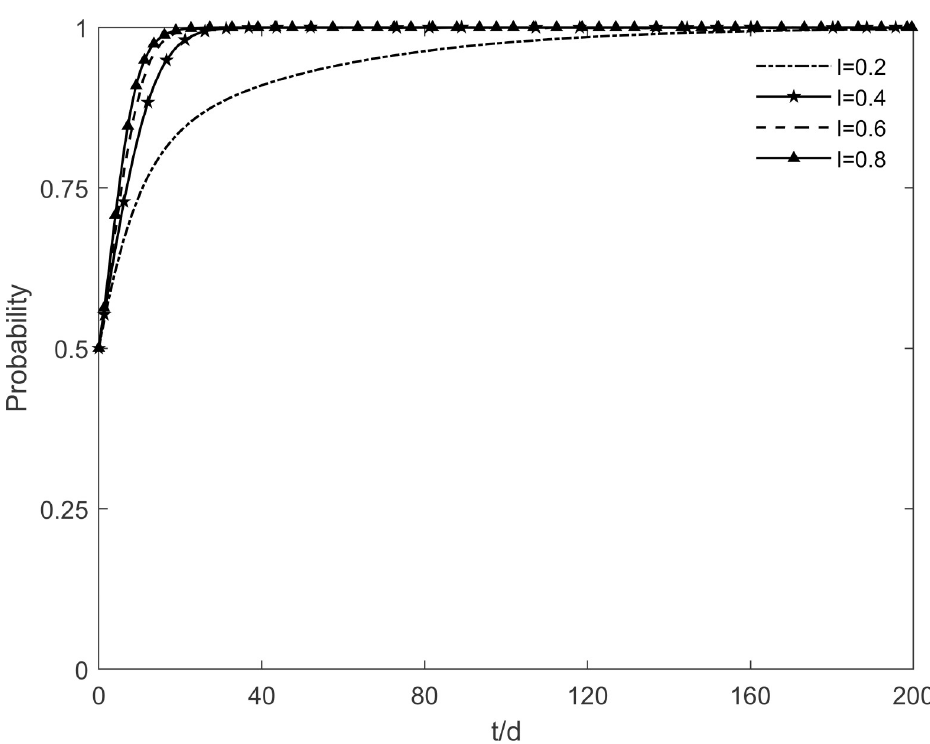
Fig 17. The impact of l on residents’ strategic choices.